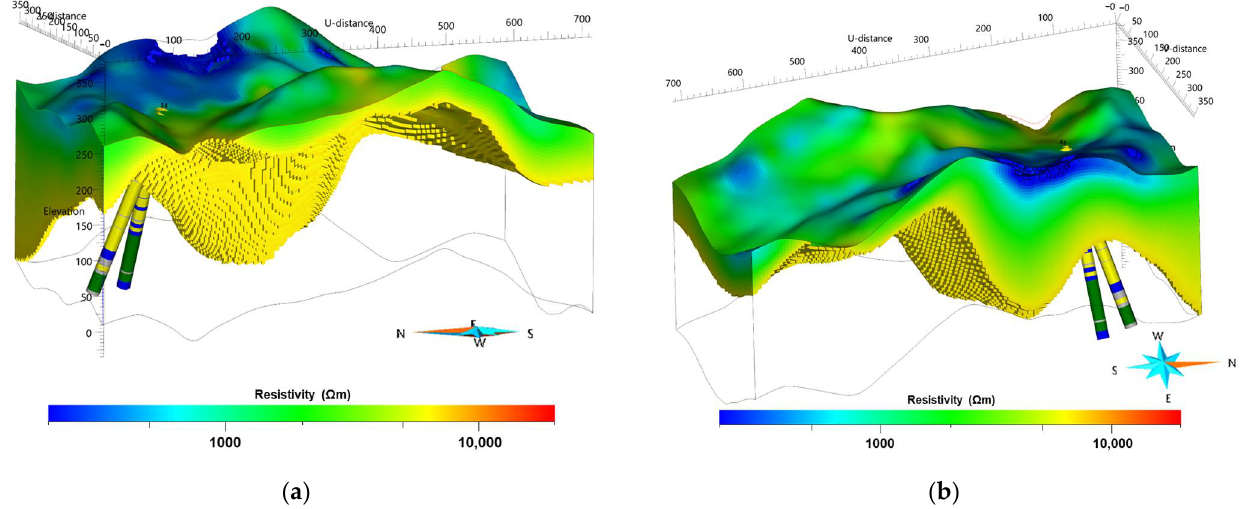
Figure 9. Three-dimensional inversion results of electrical resistivity lower than 7000 Ωm (to separate the monzogabbro– monzodiorite) according to borehole data with frontal direction of ( a ) survey line 1 and ( b ) survey line 3. The legend of drilling cores is the same as that of Figure 7.